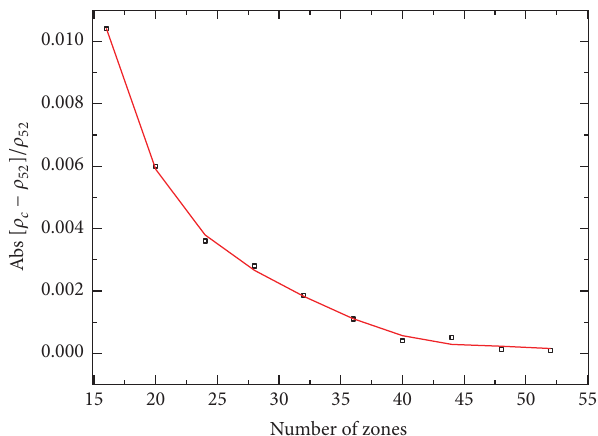
Figure 3: Plot of the error in the central density versus the number of zones across the star. It is clear that there is only a 1% error with ≈ 15 zones across the star. Increasing the number of zones across the star so that there are > 35 zones across the star produces less than a 0.1%